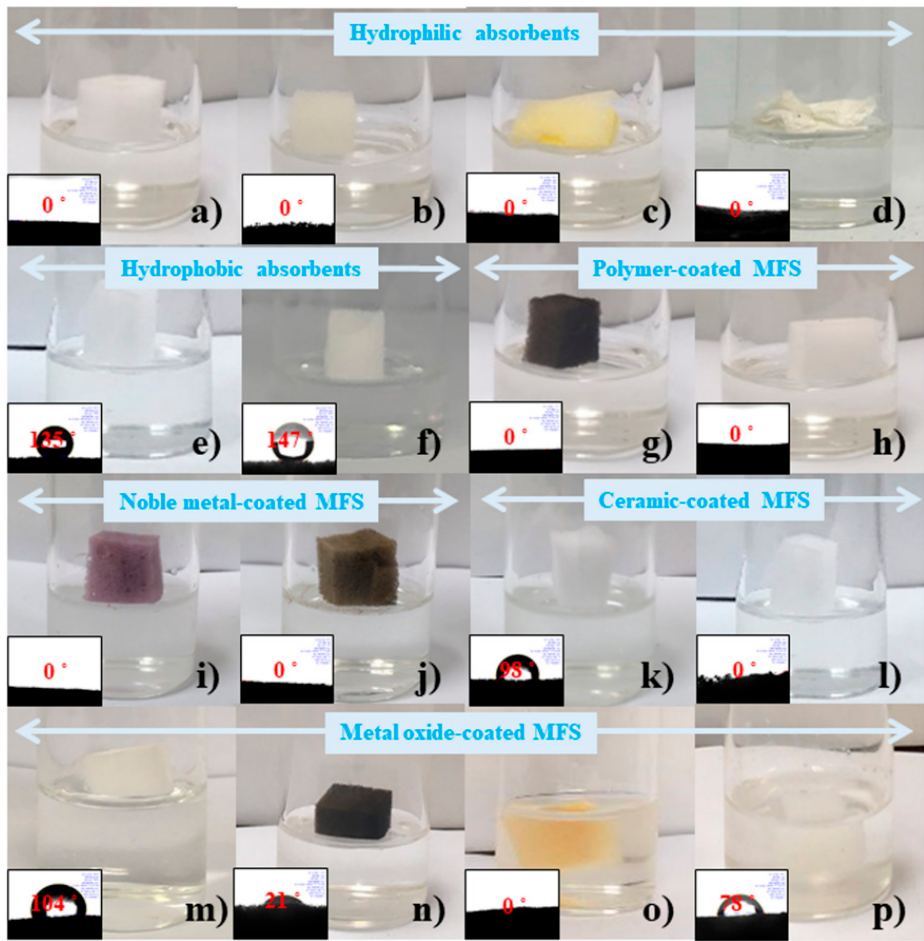
Figure 2. Drop tests of various absorbents with a strong base solution (50% NaOH). ( a – d ) Superhydrophilic absorbents. ( a ) MFS, ( b ) PUS, ( c ) absorption pad, and ( d ) cotton piece. ( e , f ) Hydrophobic material-coated MFS samples: ( e ) PDMS- and ( f ) ODA-coated MFS. ( g , h ) Superhydrophilic polymer-coated MFS samples: ( g ) Pdop- and ( h ) polyelectrolyte brush-coated MFS. ( i , j ) Noble metal-coated MFS samples: ( i ) Au- and ( j ) Ag-coated MFS. ( k , l ) Ceramic-coated MFS samples: ( k ) SiO 2 - and ( l ) CaCO 3 -coated MFS. ( m – p ) Metal oxide-coated MFS samples: ( m ) TiO 2 -, ( n